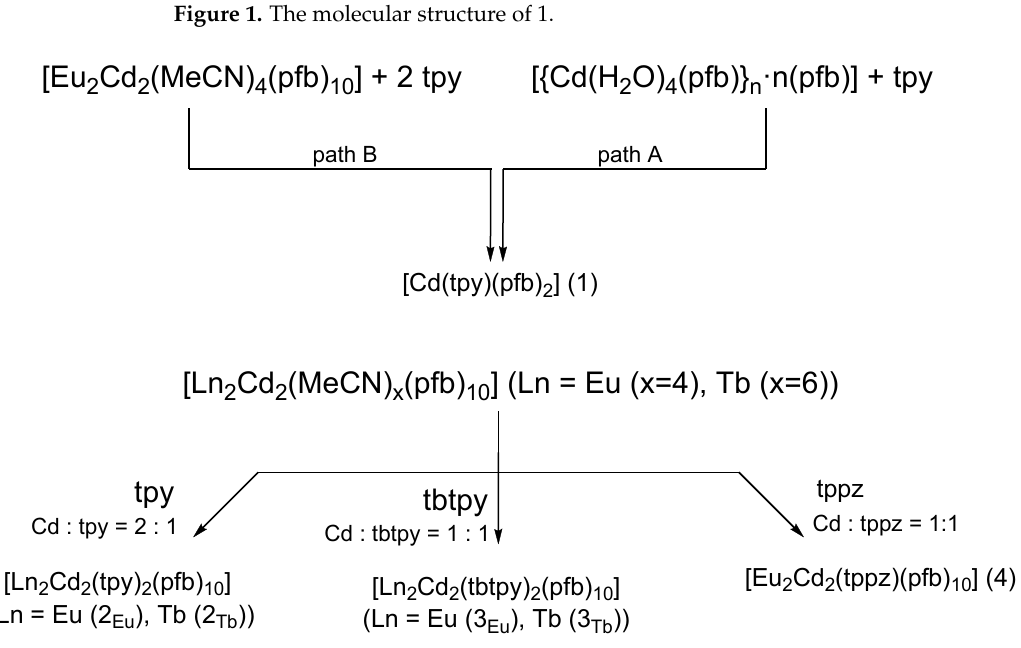
Figure 1. The molecular structure of 1.